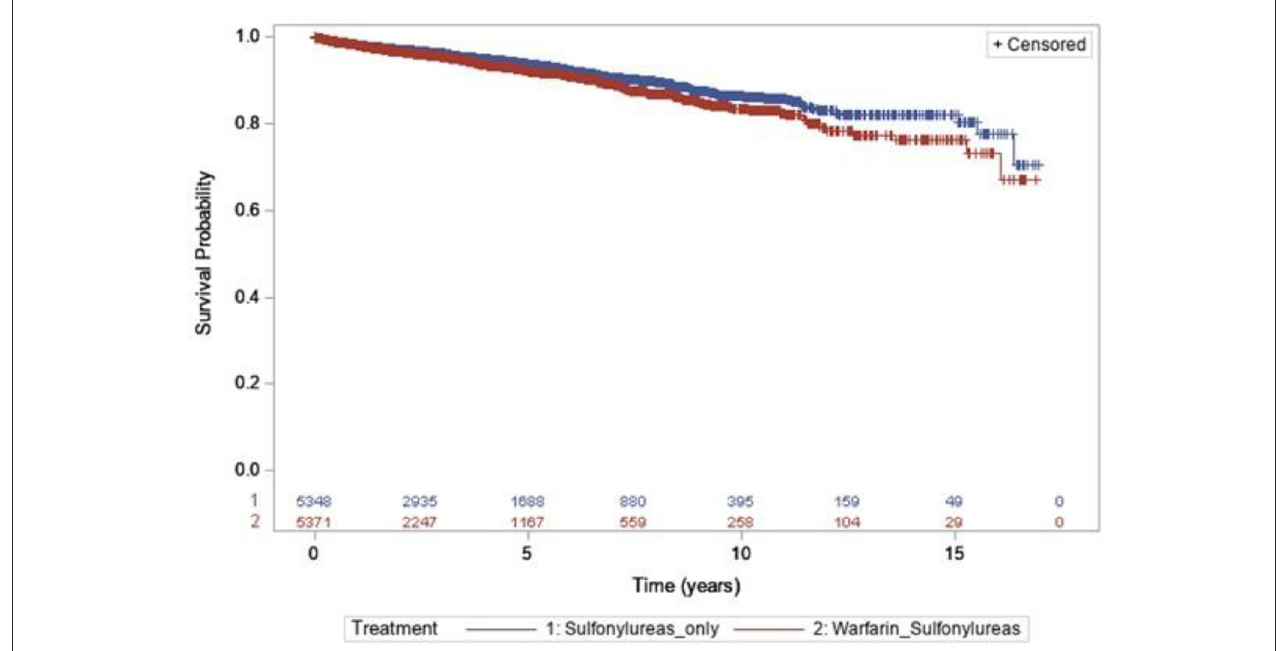
FIGURE 2 | Kaplan–Meier curves for the incidence of hypoglycemia during the follow-up period [sulfonylureas and warfarin (blue line) vs. sulfonylureas only (red line)].